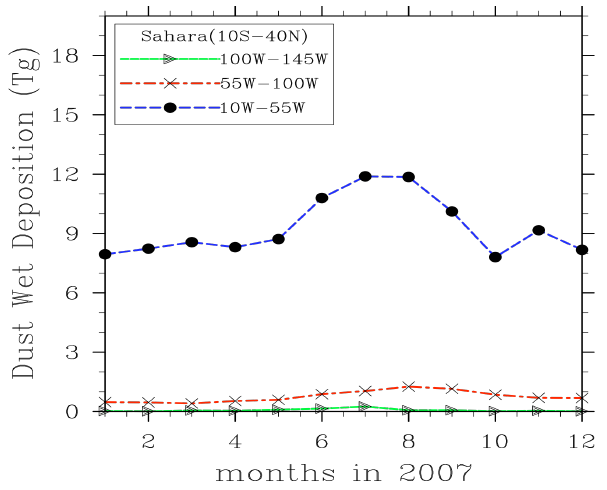
Fig. 5. Modeled monthly dust wet deposition between 10 ◦ S to 40 ◦ N for longitudes between 10 ◦ W to 55 ◦ W, 55 ◦ W–100 ◦ W, and 100 ◦ W–145 ◦ W for Saharan dust in 2007. Table 1. The factors that contribute to the magnitudes of the to- tal dust fluxes both for Asian and Saharan dust simulated from the coupled CAM3.0/CARMA2.3 model in 2007. The % in the first two lines (wet and dry deposition) refers to the fraction of the dust removed before traveling 45 degrees of longitude from the sources.